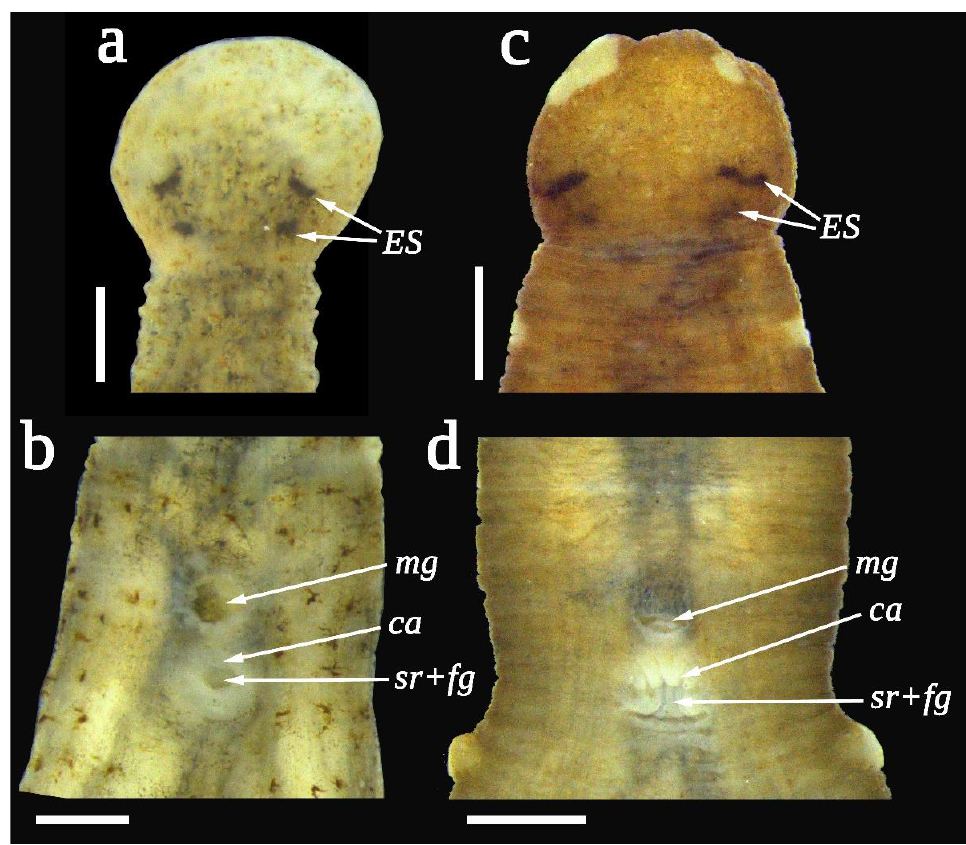
Figure 3. Morphological features of Acipenserobdella volgensis (Zykoff, 1904). ( a , b ) Specimen RMBH Hir_0189 from the mantle cavity of the duck mussel Anodonta anatina (Linnaeus, 1758) (Unionidae), Moscow River, European Russia: head region, dorsal view ( a ); section with genital pores, ventral view ( b ). ( c , d ) Free-living specimen RMBH Hir_0461_1, Moscow River, European Russia (sequenced): head region, dorsal view ( c ); section with genital pores, ventral view ( d ). Abbreviations: ES , eyespots; mg , male gonopore; sr + fg , seminal receptacle (spermatheca) opening with female gonopore; and ca , copulatory area around female genital pore. Scale bars = 0.5 mm. Photos: Tatyana A. Eliseeva.